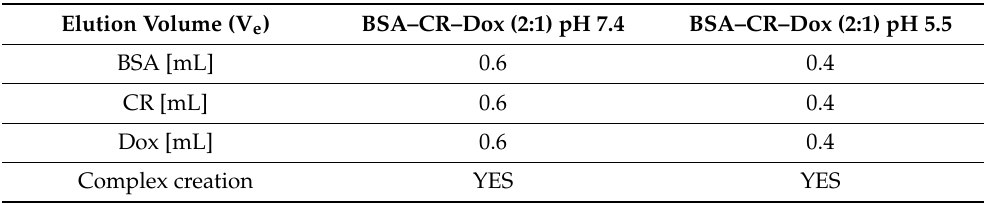
Table 2. Gel–filtration chromatography: elution volume (V e ) of BSA, CR, and Dox in mixtures of